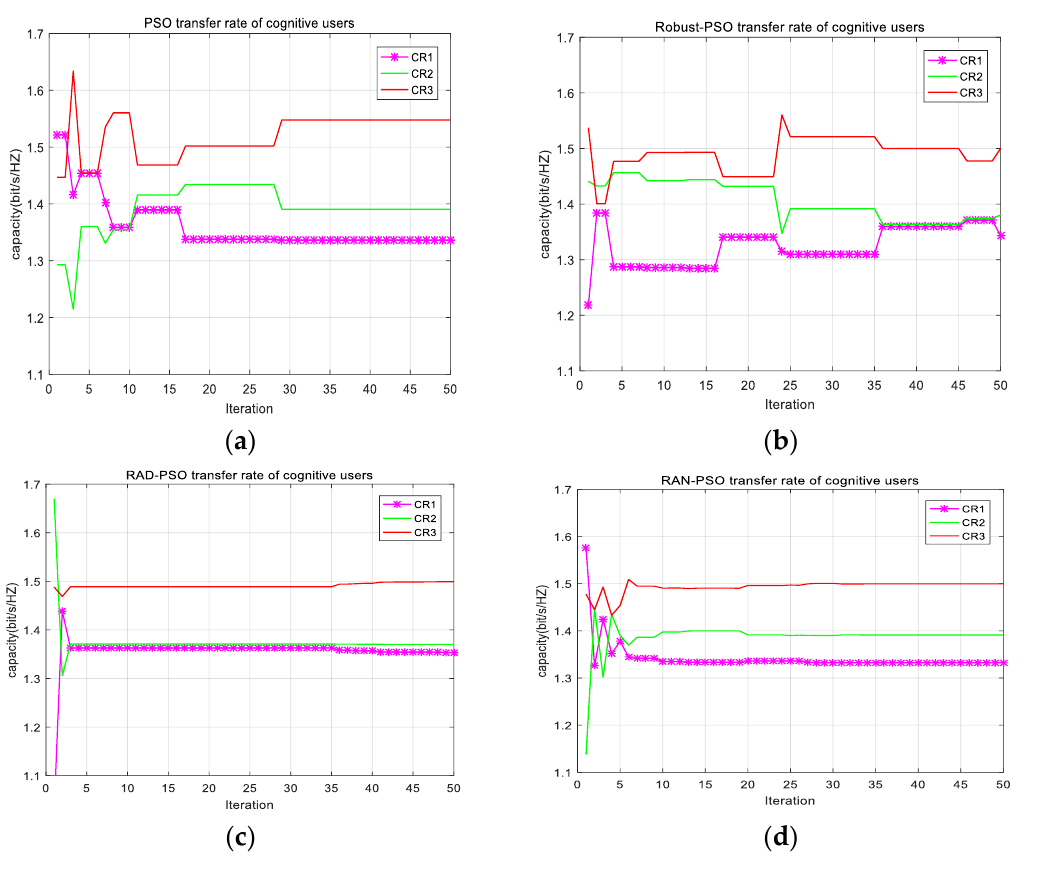
Figure 3. ( a ) Transmission rate of PSO algorithm; ( b ) transmission rate of Robust-PSO algorithm; ( c ) transmission rate of RAD-PSO algorithm; ( d ) transmission rate of RAN-PSO algorithm.